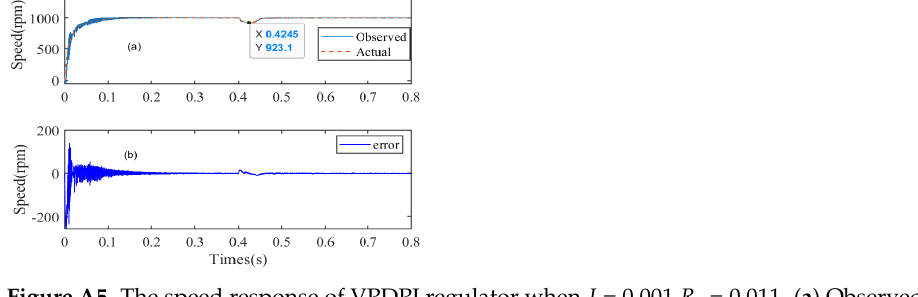
Figure A5. The speed response of VPDPI regulator when J = 0.001 R s = 0.011. ( a ) Observed speed and actual speed. ( b ) Estimation error